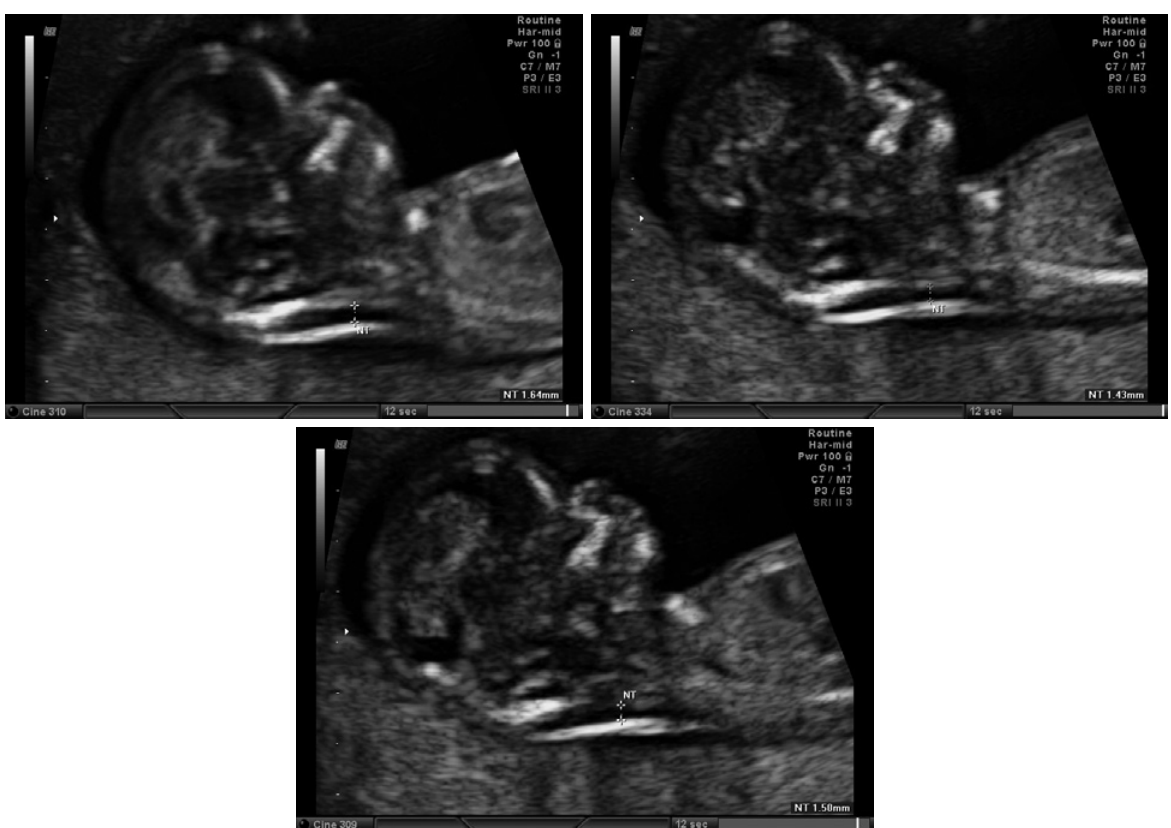
Fig. 2 - Three trials manual B-mode Ultrasound sonogram measurement results large